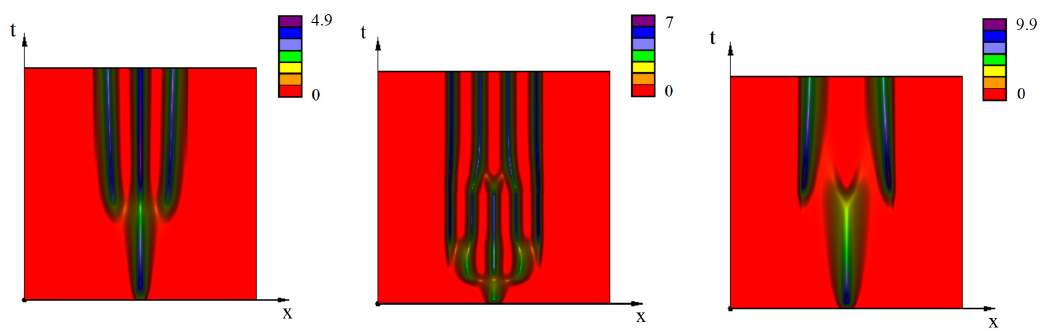
Figure 9. Numerical simulations of Equation (1). Virus evolution without immune response and with the genotype-dependent mortality σ ( x ) represented as level lines of the solution u ( x , t ) on the ( x , t ) -plane. Values of parameters: D = 10 − 5 , r = 1, q = 1, N = 0.09 ( left ), N = 0.08 and 0.09 ( middle ), N = 0.2 ( right